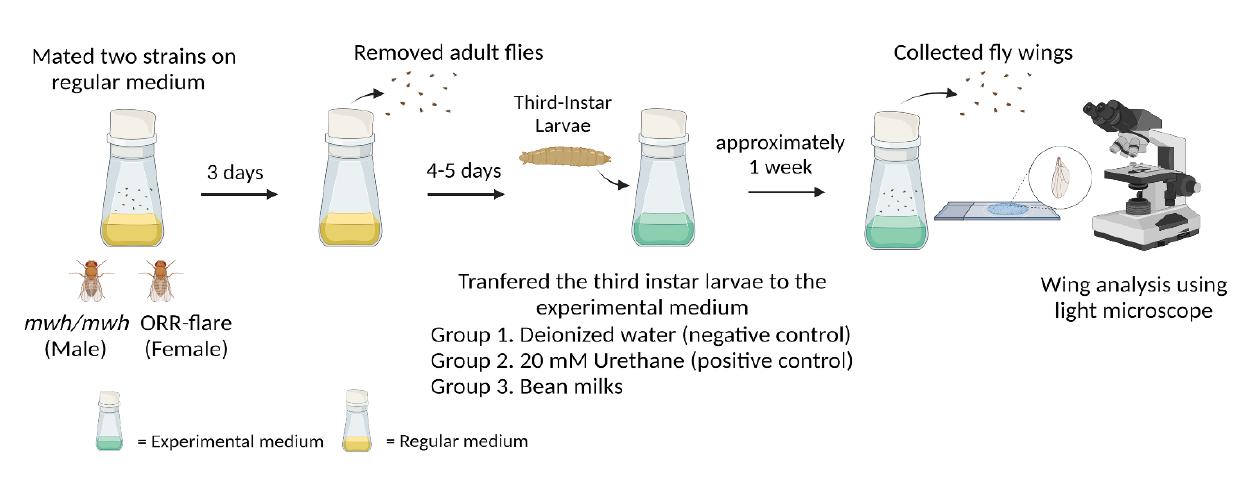
Figure 1. Experimental design of the co-administration study for mutagenicity testing: crossed adult flies were fed on the regular medium and the third instar larvae were transferred to the experimental medium containing each bean milk, water (negative control) or 20 mM urethane (positive control). Wings were collected and analyzed for mutant spots.